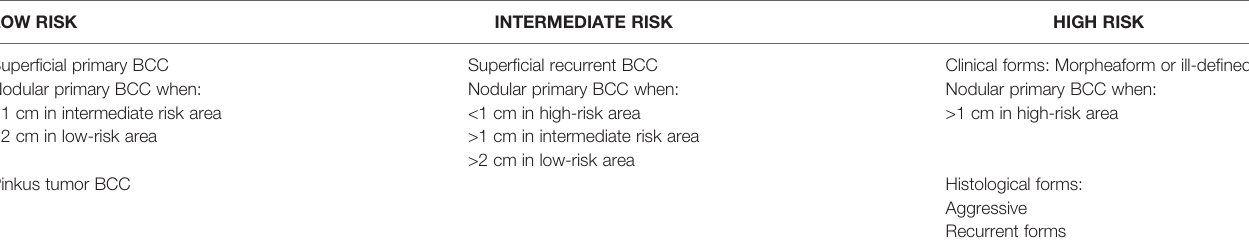
TABLE 1 | Classi fi cation of BCC according to risk for recurrence (105,